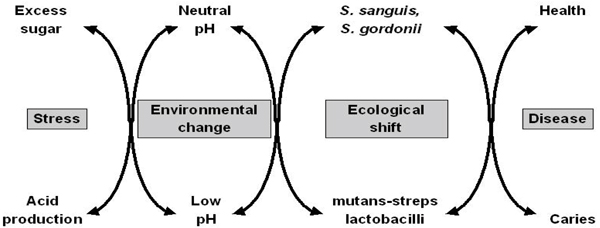
The "ecological plaque hypothesis" and the prevention of dental caries. Caries is a result of changes in the environment due to acid production from the fermentation of dietary carbohydrates, which selects for acidogenic and acid-tolerating species such as mutans streptococci and lactobacilli. Disease could be prevented not only by targeting the putative pathogens directly, but also by interfering with the key environmental factors driving the deleterious ecological shifts in the composition of the plaque biofilms [32].